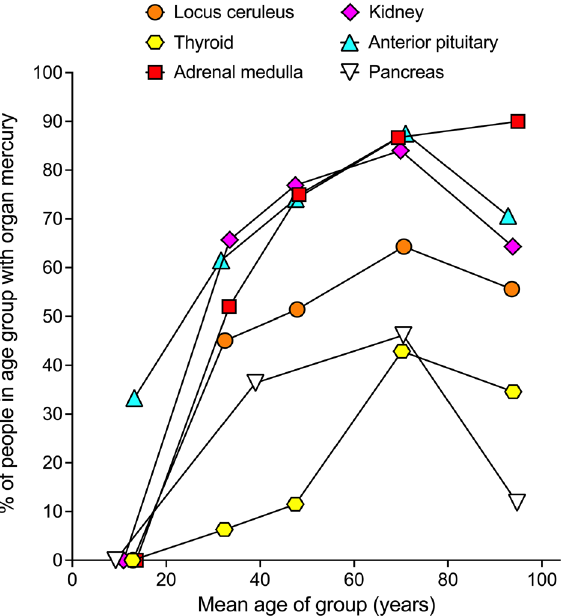
Figure 3. Age-related prevalence of mercury in six organs. In five organs the prevalence of people with iHg increased on aging up to the 61–80 years group. In the > 80 years group (the very old), a large fall in the iHg prevalence from the previous peak value was seen in the pancreas, with moderate falls in the kidney and pituitary, and smaller falls in the locus ceruleus and thyroid. The iHg prevalence in the adrenal medulla rose slightly in the very